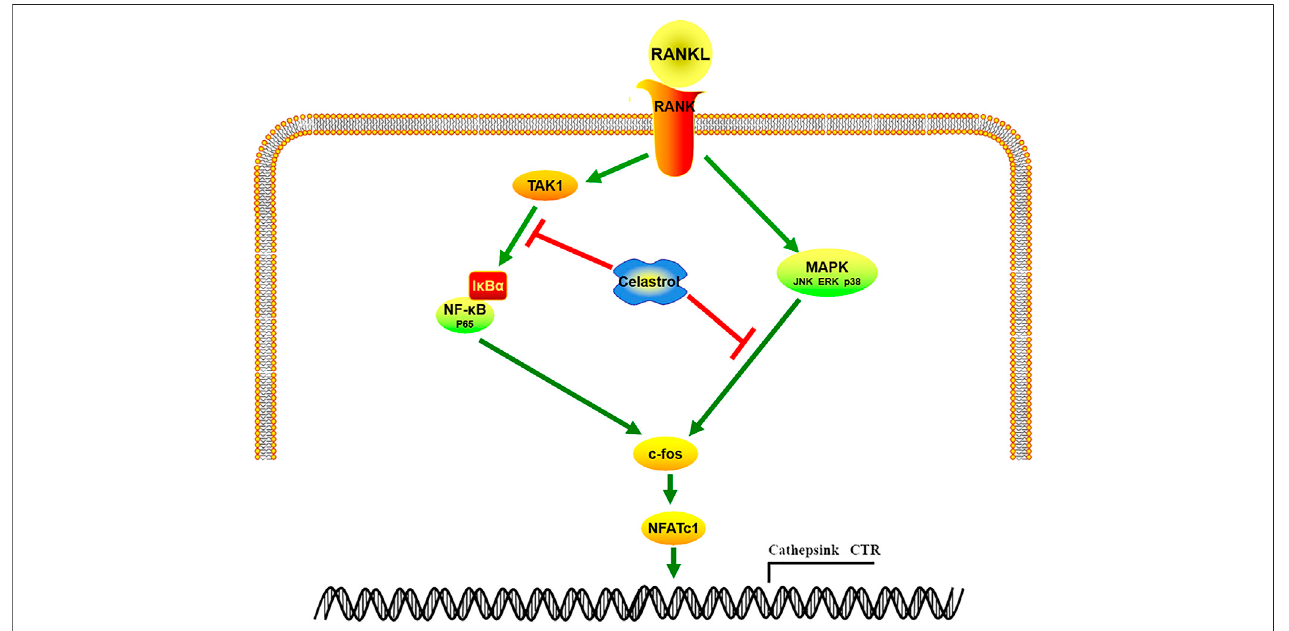
FIGURE 7 | Diagram of celastrol ’ s inhibitory impact on osteoclast differentiation through the TAK1-mediated NF- κ B and MAPK (JNK, ERK, p38) signaling pathways.